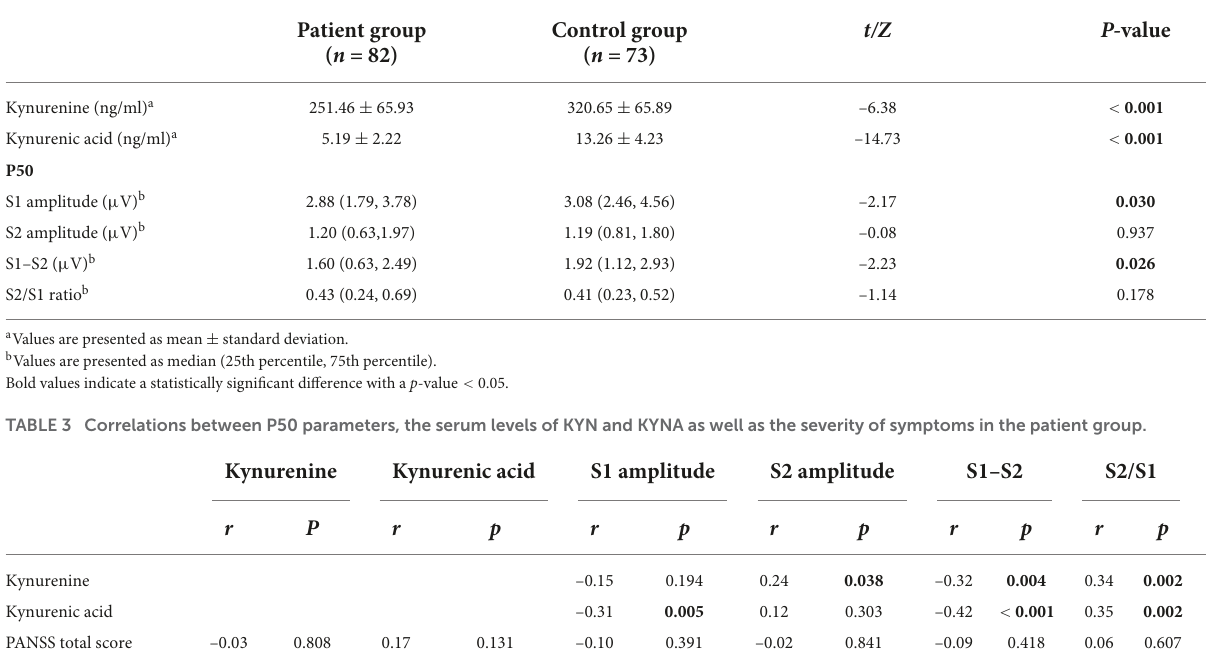
TABLE 2 Comparisons of P50 parameters and serum levels of KYN and KYNA between patients and healthy controls.